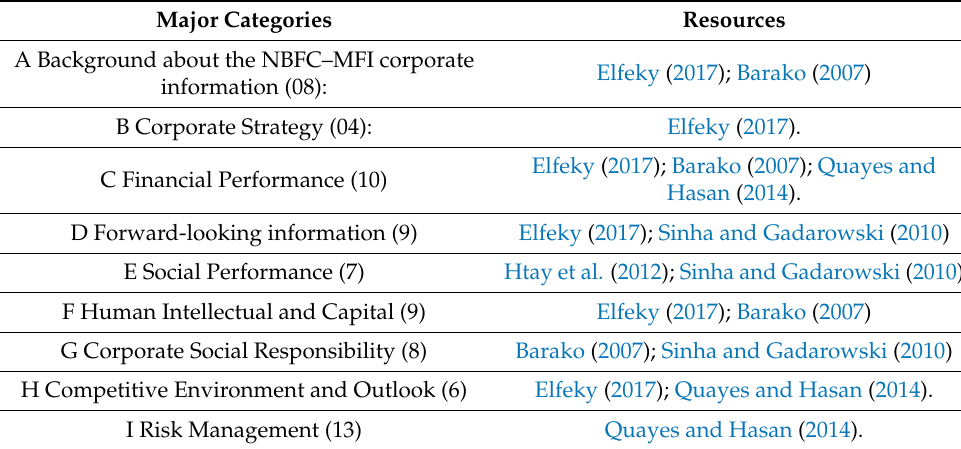
Table 1. The categories for voluntary disclosure